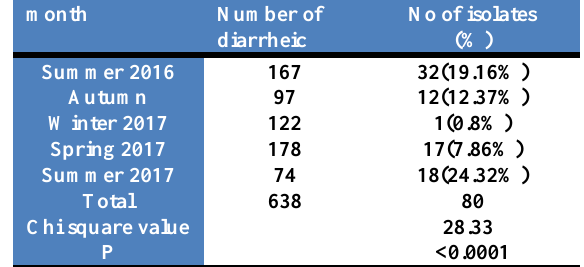
Table, 7: Isolation of Campylobacter spp. during different